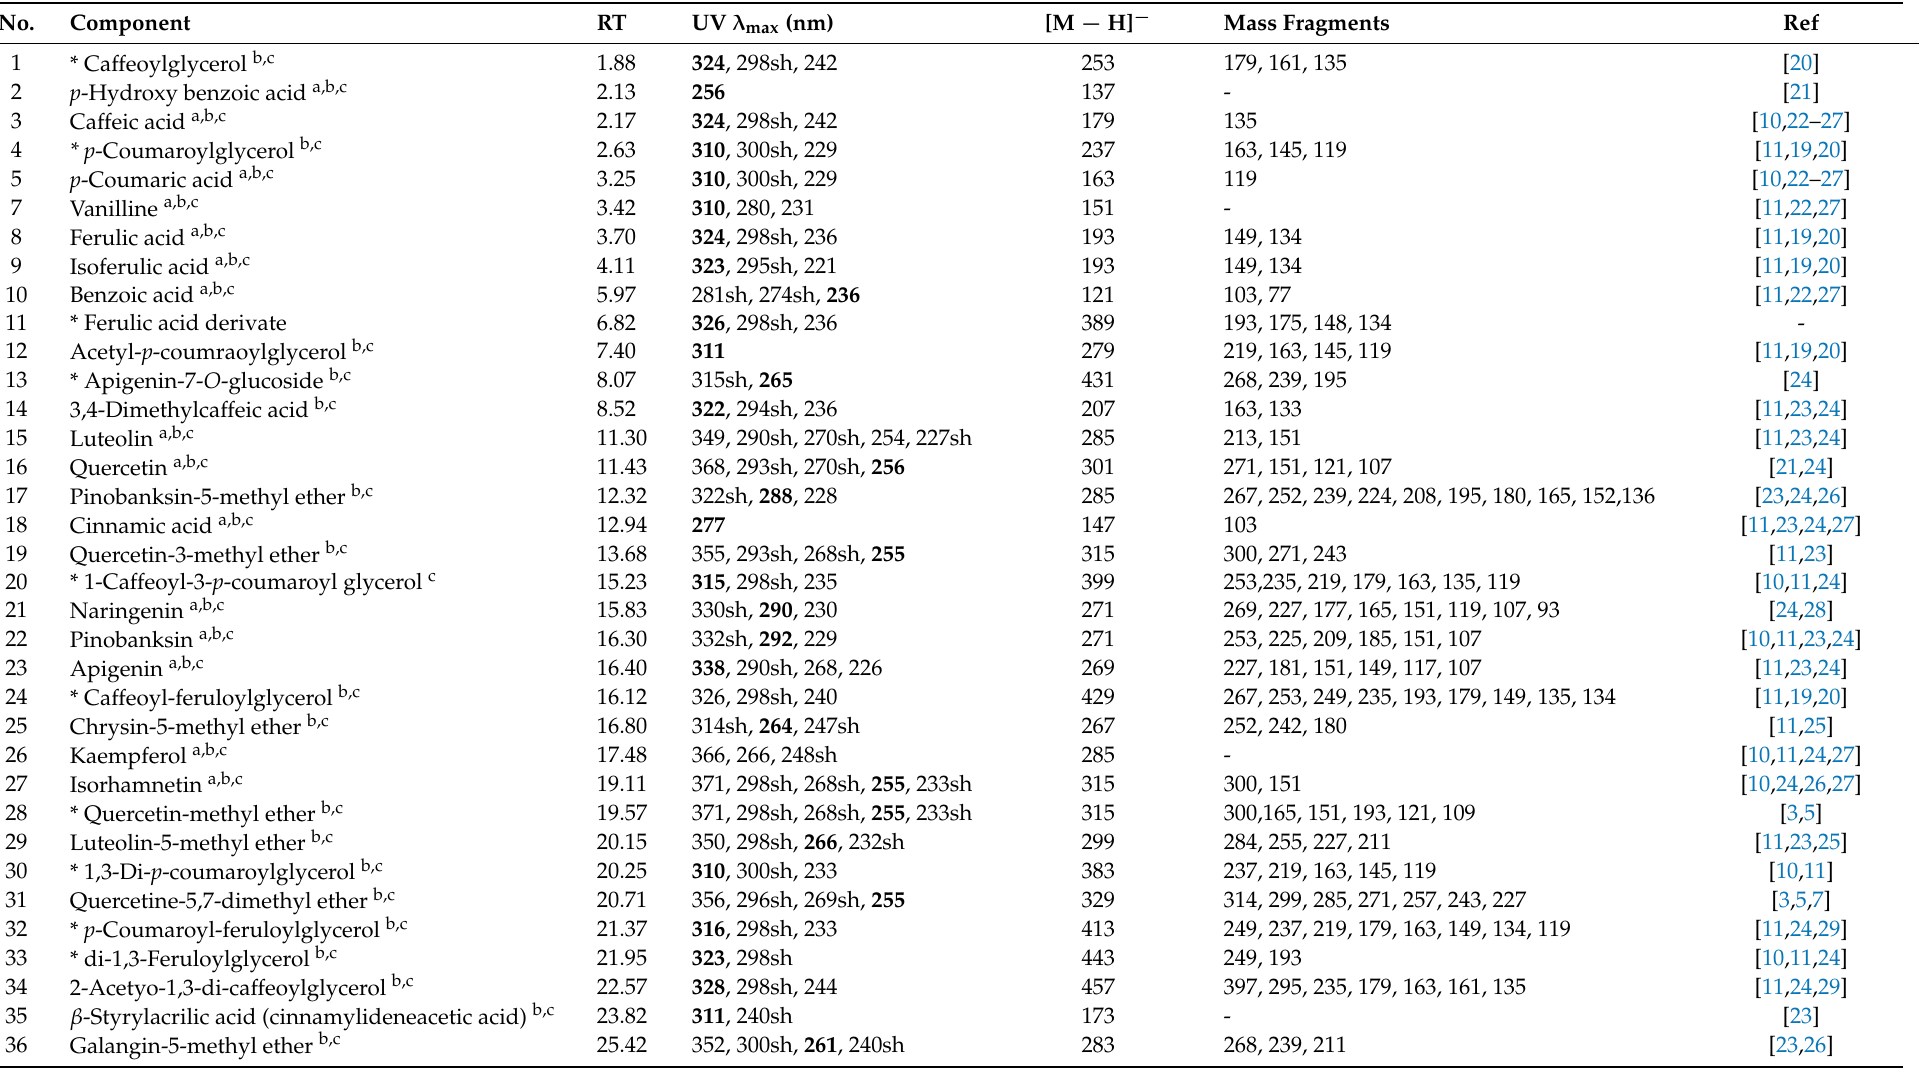
Table 1. UPLC-DAD-MS analysis of Eurasian